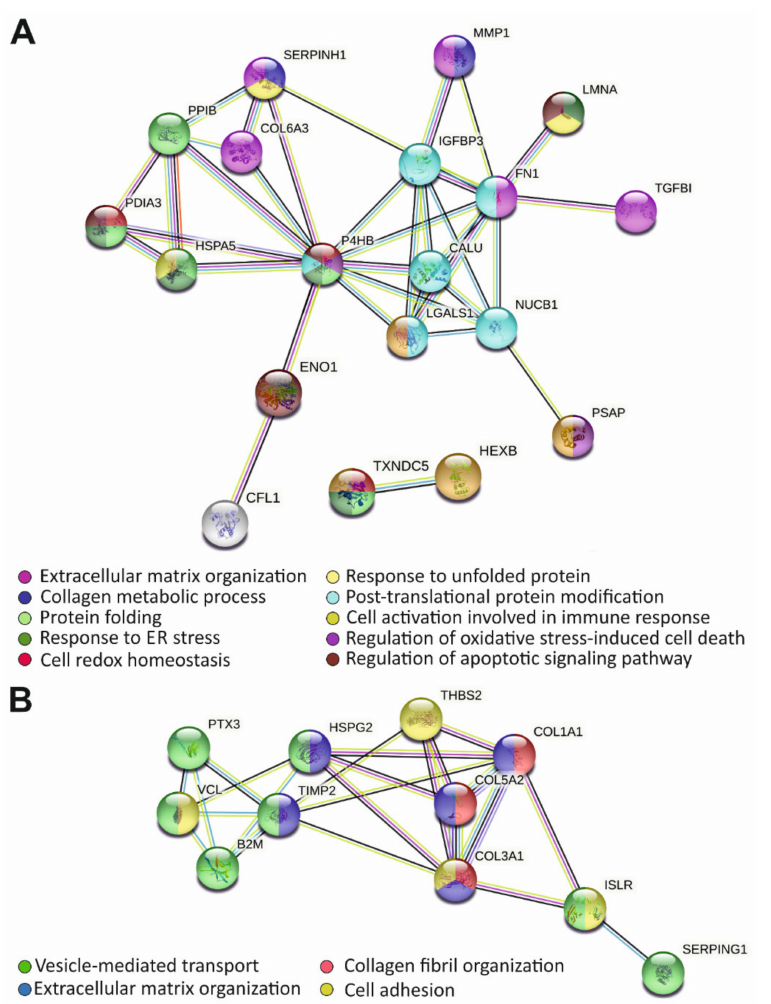
Figure 2. STRING analysis uncovering protein-protein interactions of up- ( A ) and down-regulated ( B ) proteins identified in the secretome of hEDS cells. Each node represents a protein, and each edge represents an interaction including either physical or functional associations. Only interactions with the highest confidence score (0.9) are